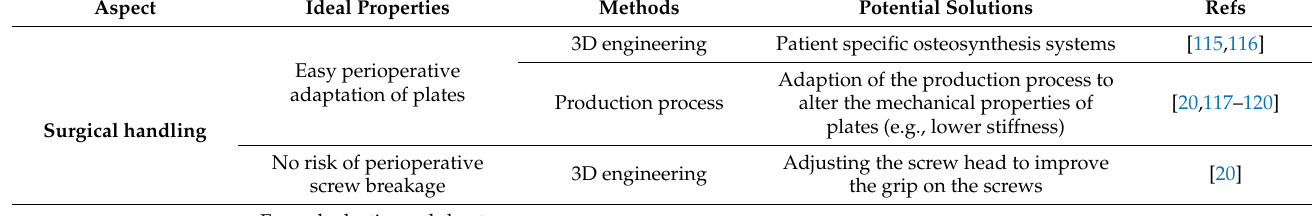
Table 3. Different aspects of titanium osteosynthesis systems accompanied with the ideal properties and the potential solutions to accomplish these